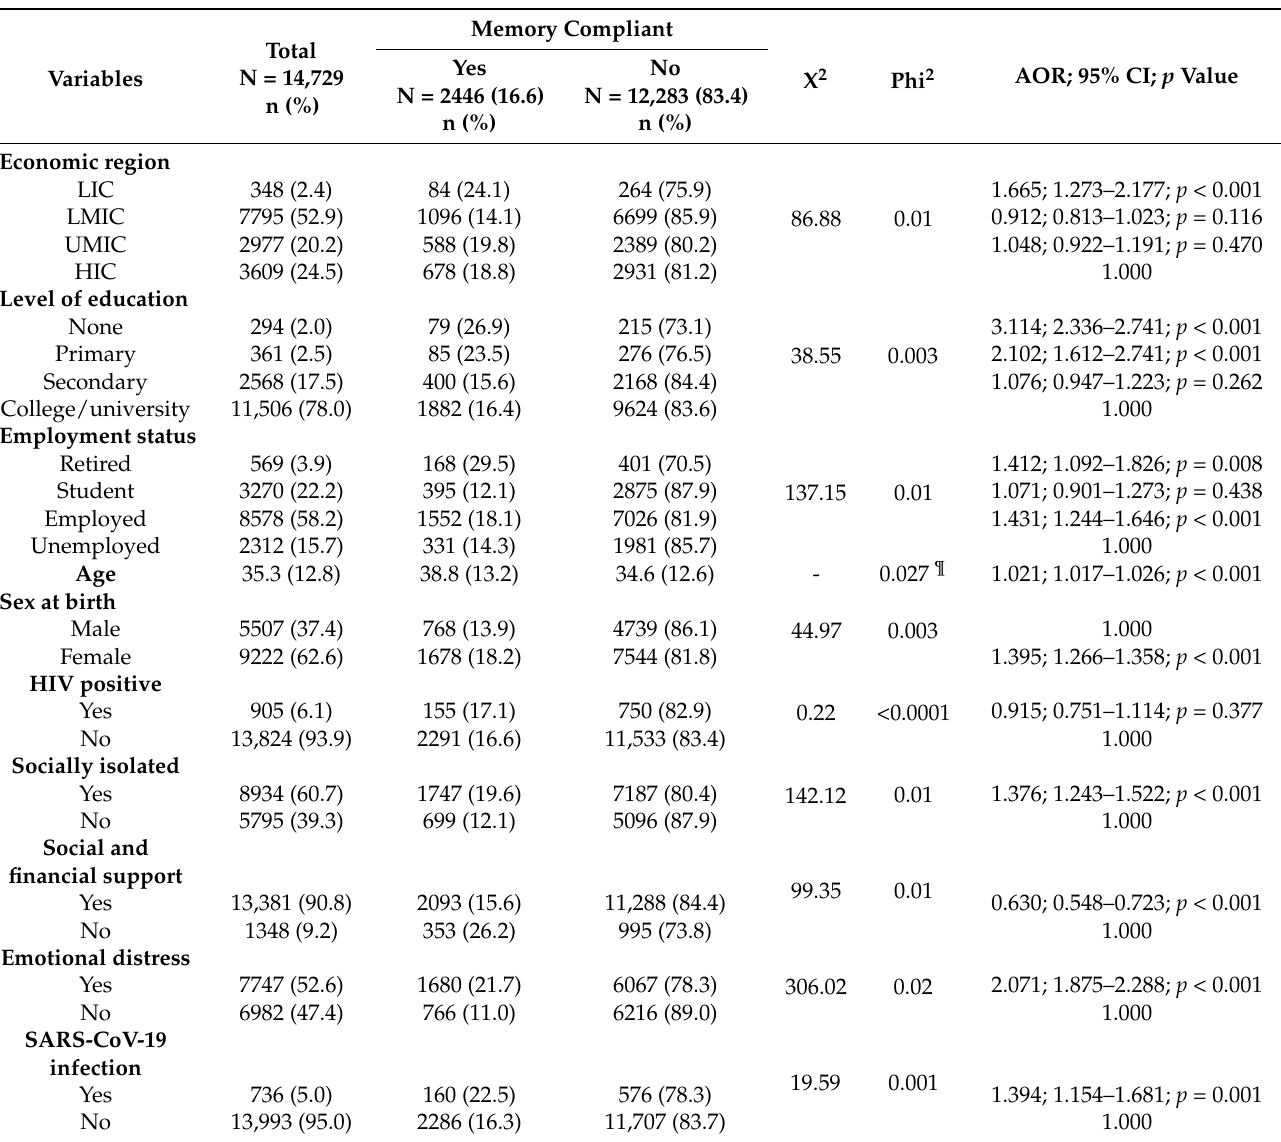
Table 1. Multivariable logistic regression analysis to determine factors associated with memory complaints among adults who participated in the global survey (N =